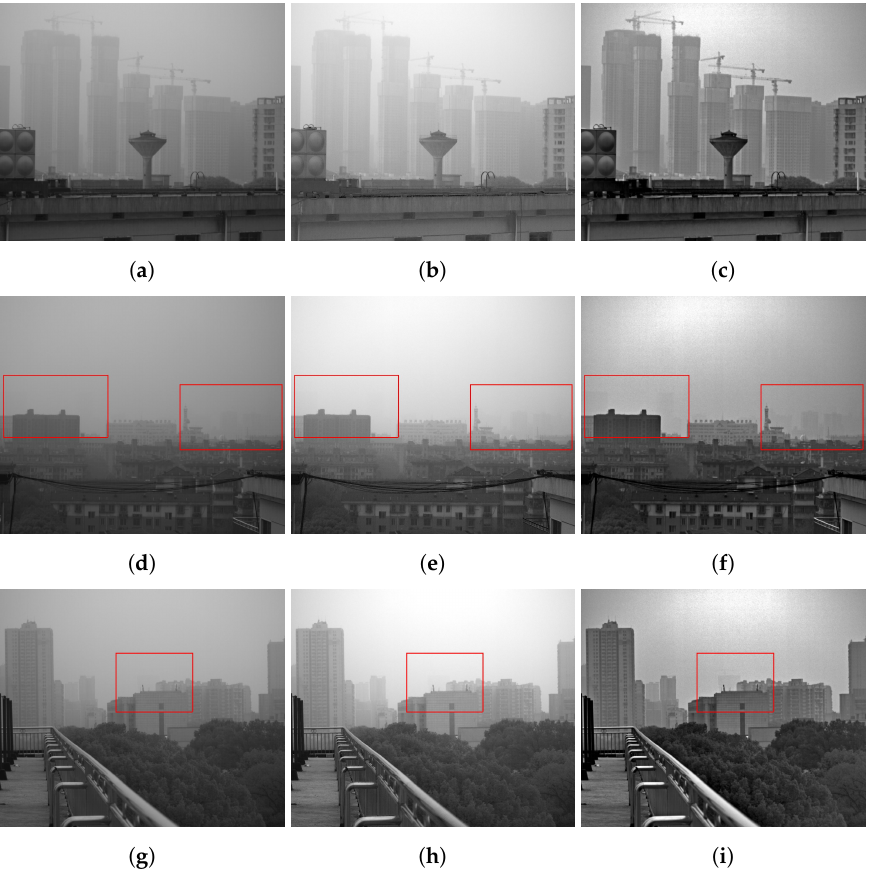
Figure 5. Comparisons between the original images and the dehazed images in light hazy back- ground. ( a , d , g ) are the original images; ( b , e , h ) are the images dehazed by Schechner’s method; ( c , f , i ) are the images dehazed by our